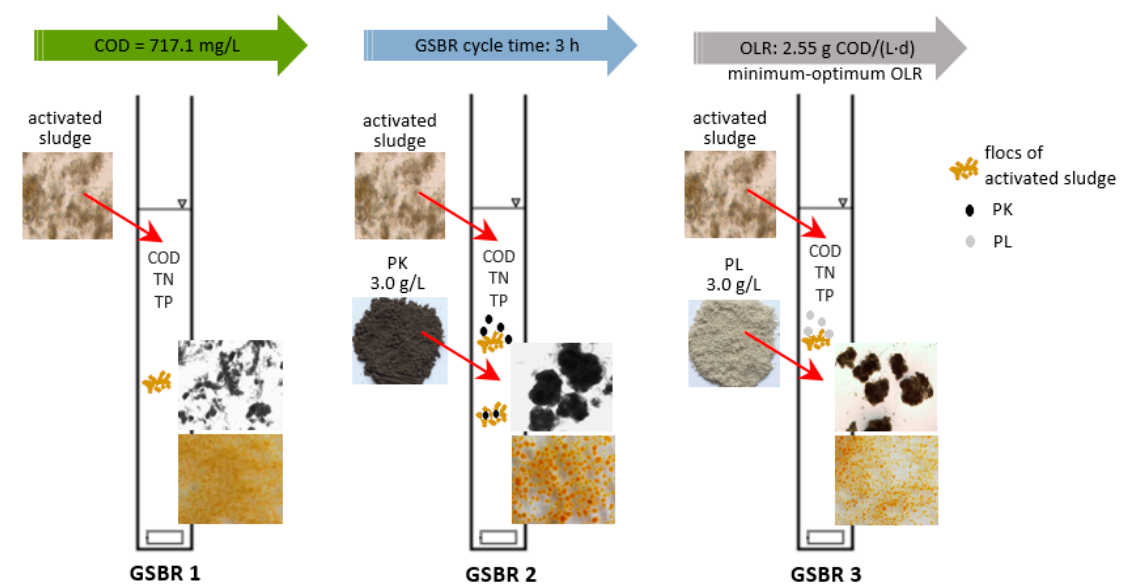
Figure 1. Graphic representation of the way the research was conducted.